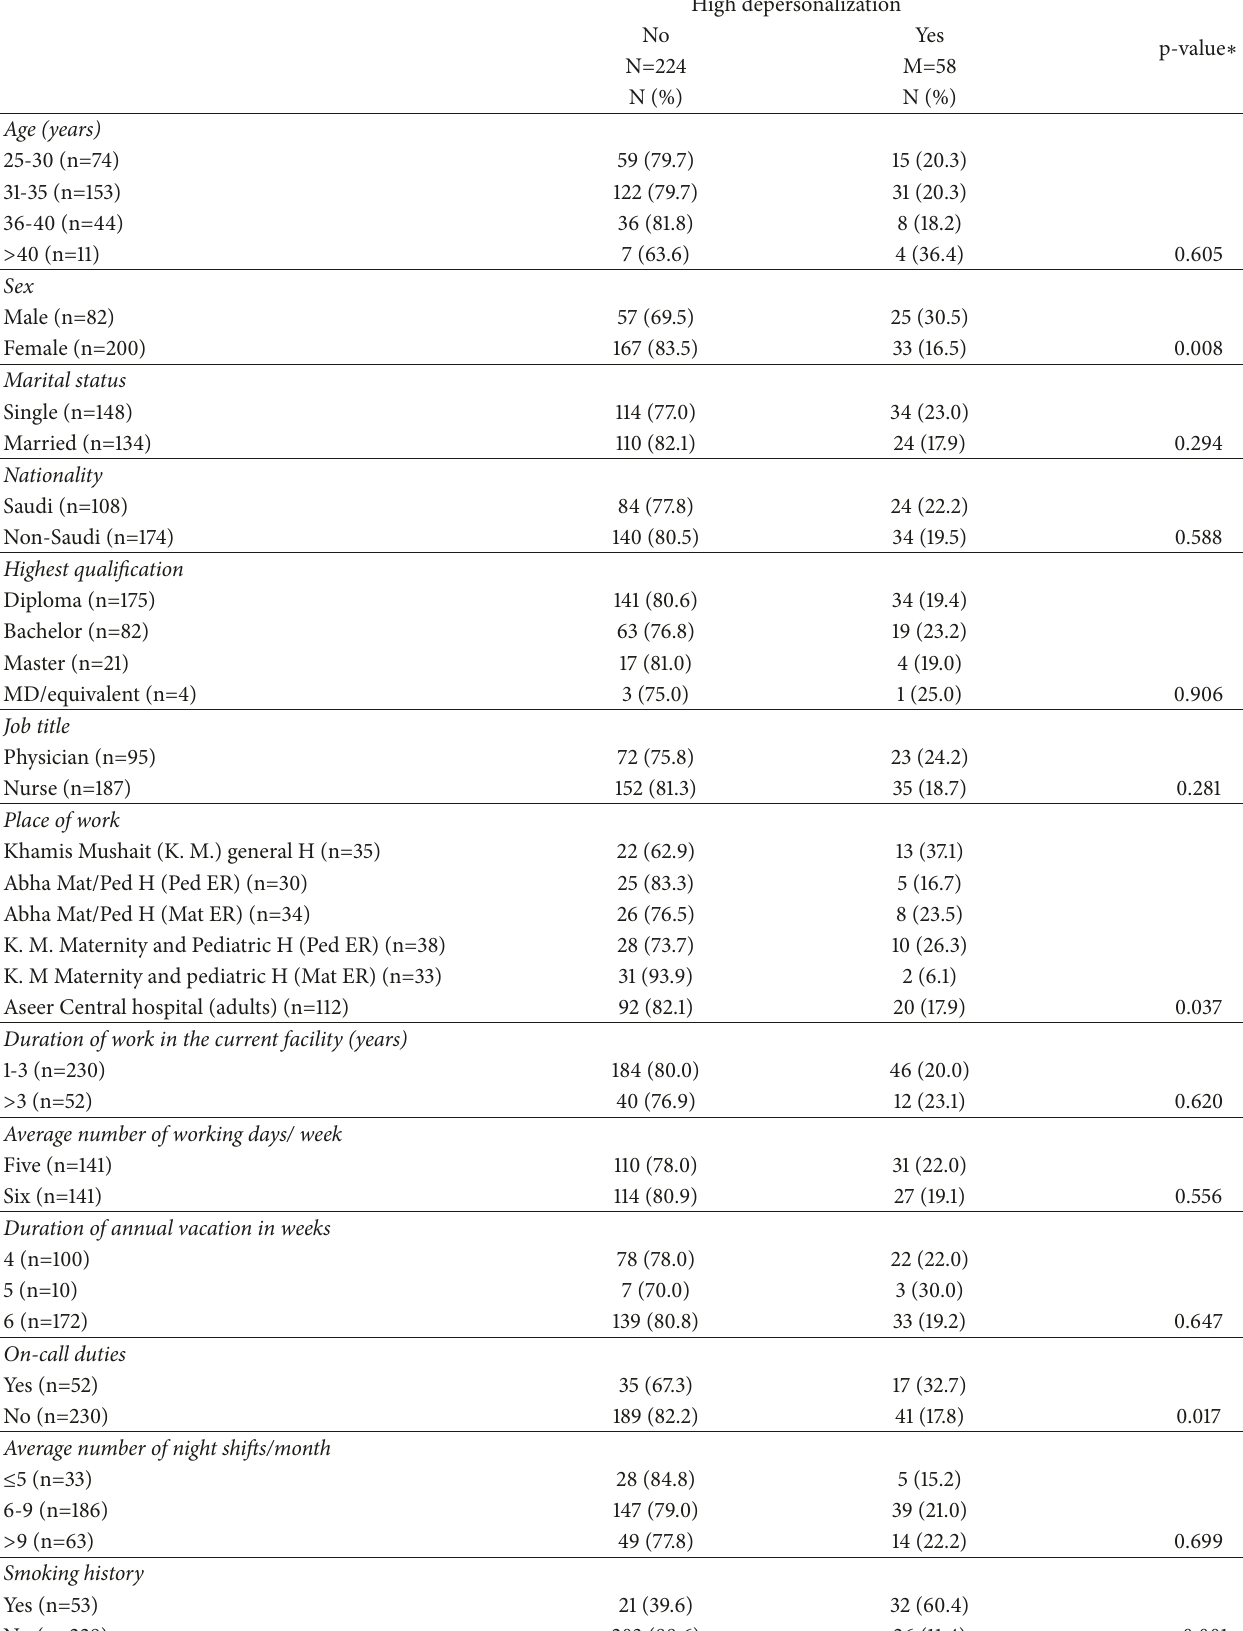
Table 4: Factors associated with high depersonalization (cynicism) among emergency healthcare